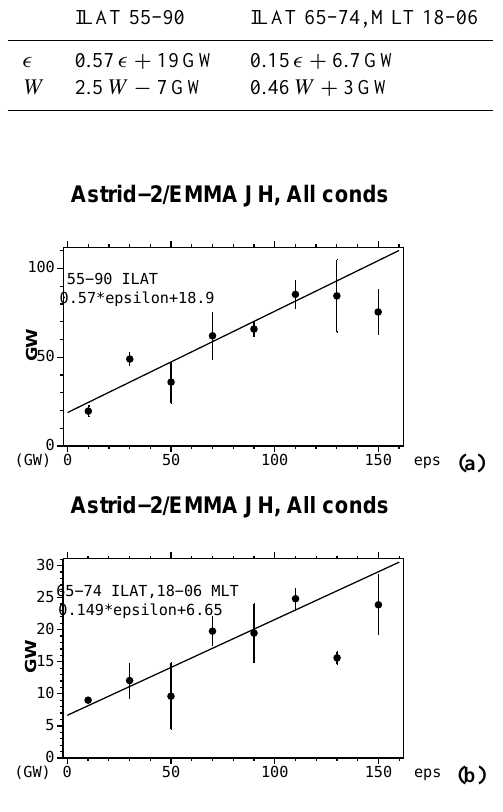
The Joule heating depending on the epsilon parameter (Eq. 8) for (a) ILAT 55–90, (b) ILAT 65–74. All MLT and all solar illumination conditions are included. The solid lines corresponds to a fit to the data and the corresponding formula is given in each sub- plot, as well as in Table 3, row 1. Notice that the JH value is for one hemisphere only, whereas (cid:15) is a global parameter; hence, the result that JH and (cid:15) are equal in this plot means that (cid:15) underestimates the energy input.